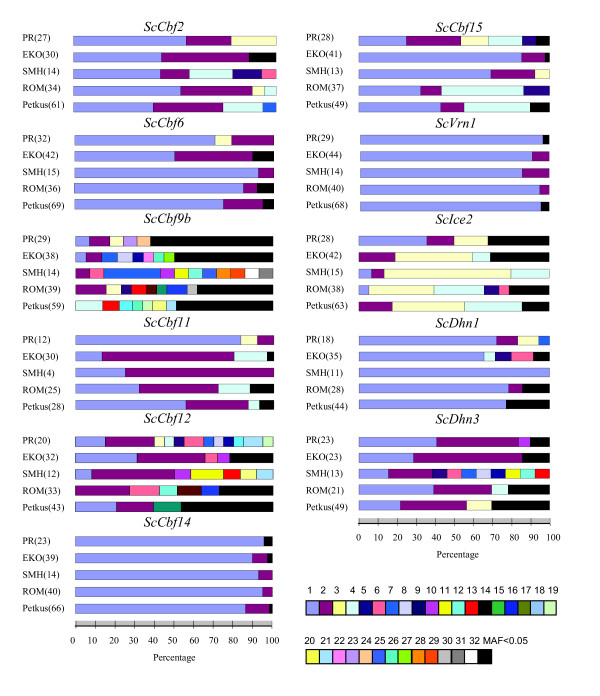
Haplotype frequencies of eleven candidate genes in five rye populations (PR, EKO, SMH, ROM, Petkus). The different haplotypes occurring within each gene are represented by different coloured bars (see legend). Haplotypes occurring at a frequency < 0.05 are pooled and shown as black bars. The number of investigated lines in each population is shown in brackets.